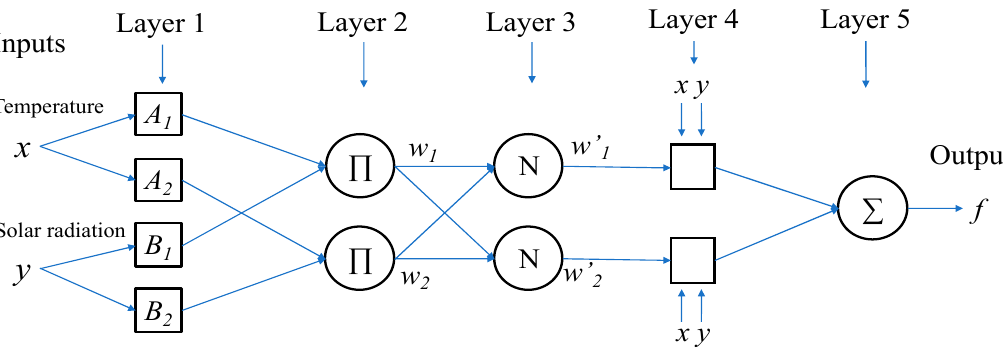
Figure 4. The structure of the adaptive neuro-fuzzy inference systems (ANFIS) model.